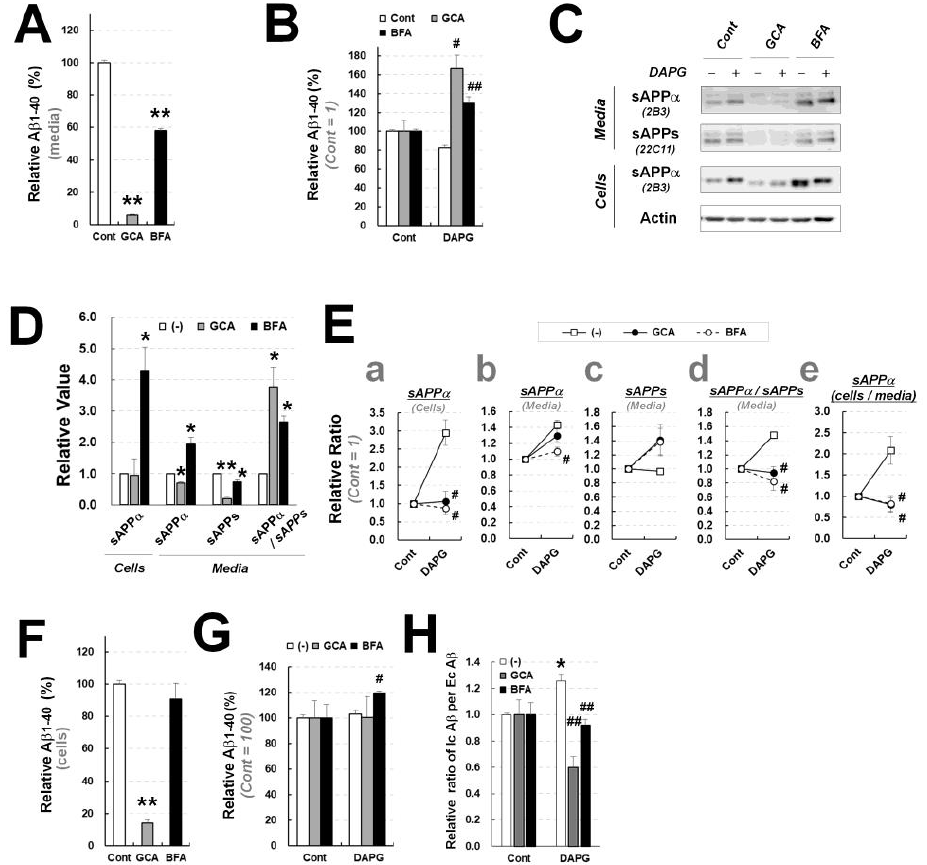
Figure 10. Examination of GCA and BFA effects on DAPG-mediated A β level decrease and sAPP α level increase in primary astrocytes from APPsw/PS1dE9 transgenic mice. ( A ) ELISA analysis of A β 1–40 levels in the culture medium of primary astrocytes treated with 3.5 µ M GCA or 60 ng/mL BFA for 8 h. ( B ) Relative A β 1–40 content in the medium of primary astrocytes treated with 30 µ M DAPG in the presence or absence of 3.5 µ M GCA or 60 ng/mL BFA for 8 h obtained by ELISA analysis. ( C ) Immunoblot analysis of sAPP α and sAPPs levels in the primary astrocytes treated with DAPG and GCA or BFA for 8 h. ( D , E ) Densitometry analysis of sAPP α and sAPPs levels in the medium or cells from immunoblots presented in ( C ). Panel D shows the effects of GCA or BFA alone ( D ). Panel E shows the ratio between controls and cells treated with DAPG (untreated) or DAPG and GCA or BFA ( E ). The levels of sAPP α in cells ( a ) and the medium ( b ) and sAPPs in the medium ( c ) as well as the ratios of sAPP α to sAPPs levels in the medium ( d ), and of sAPP α levels in cells to those in the medium ( e ) are shown. ( F , G ) ELISA analysis of intracellular A β 1–40 levels in primary astrocytes treated with GCA or BFA ( F ) and of relative A β 1–40 content after DAPG and GCA or BFA co-treatment ( G ). ( H ) Ratios of A β 1–40 levels in cells (Ic A β ) to those in the medium (Ec A β ) after DAPG and GCA or BFA co-treatment. Statistical significances of differences between treated and untreated groups in panels A, D, and F were determined using Student’s t -test (* p < 0.05, ** p < 0.01). In panels B, E, G, and H, statistical significances of differences between untreated and DAPG-treated groups (* p < 0.05) and between DAPG-treated and DAPG- and GCA- or BFA-treated groups ( # p < 0.05, ## p < 0.01) were determined using one-way ANOVA followed by Tukey’s test.